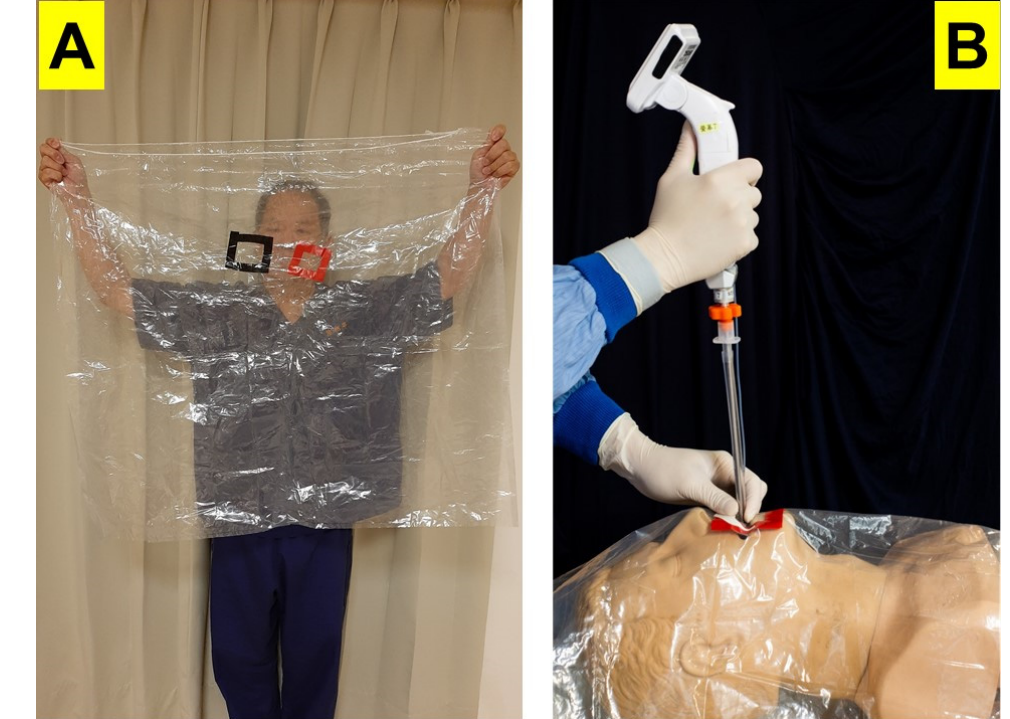
Figure 11. Modification of plastic sheet barrier with ( A ) small incisions marked by colored tape to ( B ) allow passage of intubation device from above the sheet.